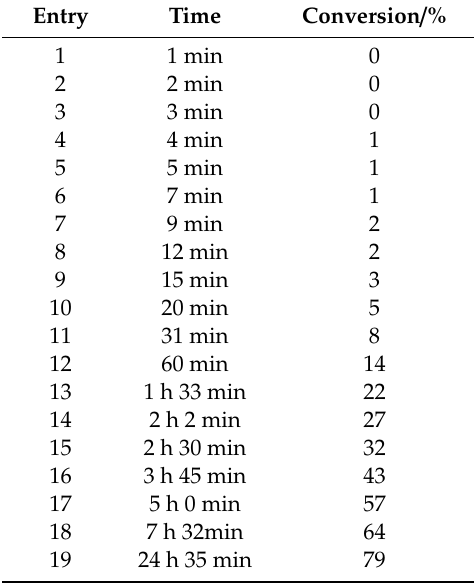
Table A13. Reduction of acetophenone ( 1 ) to 1-phenylethanol ( R )- 2 . Change from standard procedure: powdered superabsorber (particle size < 100 µ m).